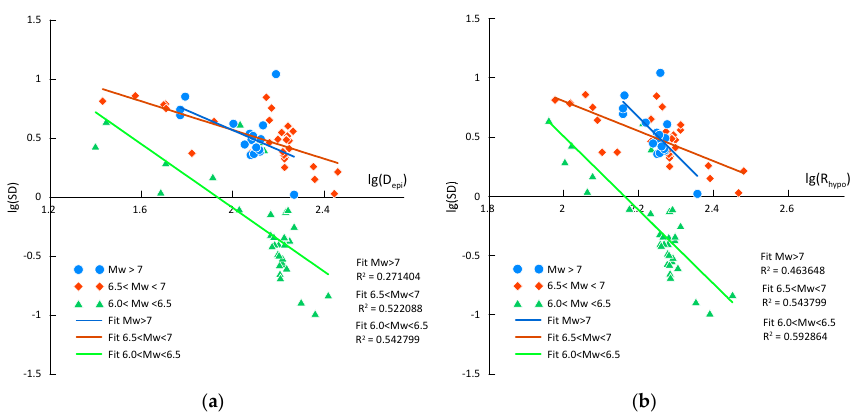
Figure 3. Correlation of the logarithm of spectral displacement with epicentral and hypocentral distance for T = 1.0 s, soil type B ( a ) Correlation with the epicentral distance; ( b ) Correlation with the hypocentral distance.